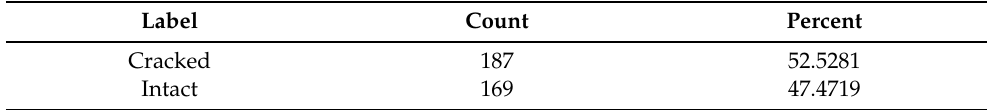
Table 1. The number of egg samples used by the electrical characteristic crack detection system to obtain a microcurrent